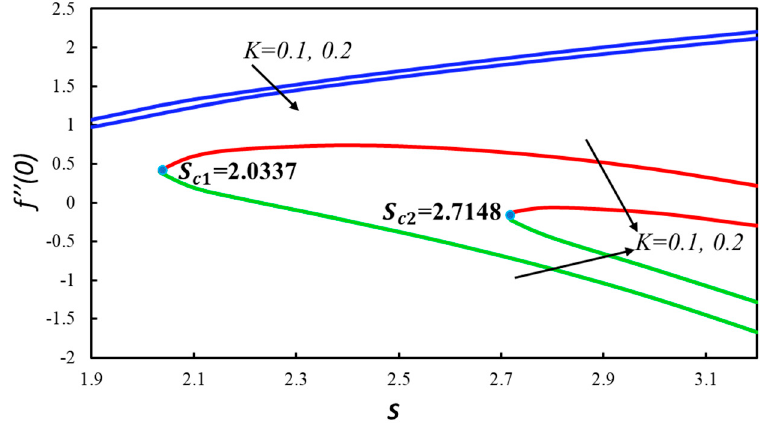
Figure 15. Coe ffi cient of the skin friction with various values of S Figure 15. Coefficient of the skin friction with various values of (cid:1845) .